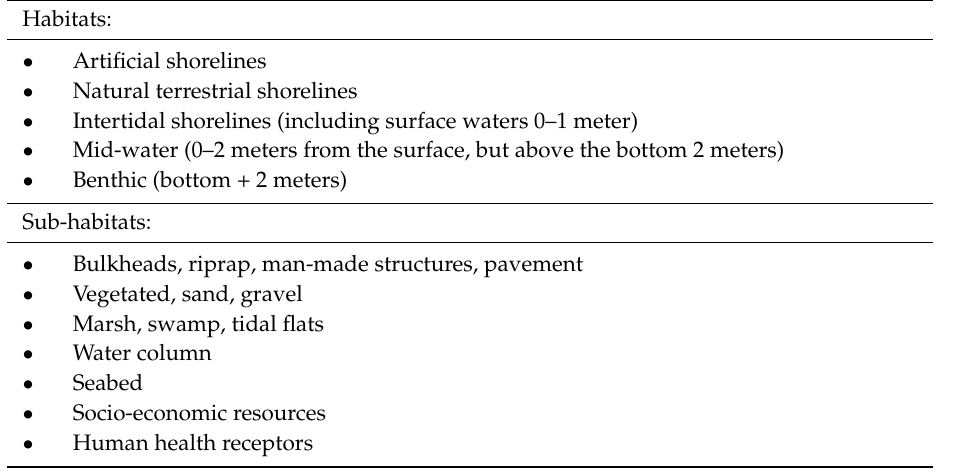
Table 2. Organization of resources of concern and at risk from Bakken and dilbit oil spills in marine, brackish water, and freshwater environments in a temperate climate in the mid-Atlantic coast of the USA, encompassing Delaware